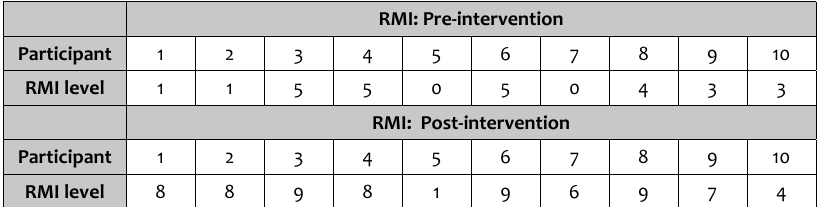
Table 7: Non-intellective factors